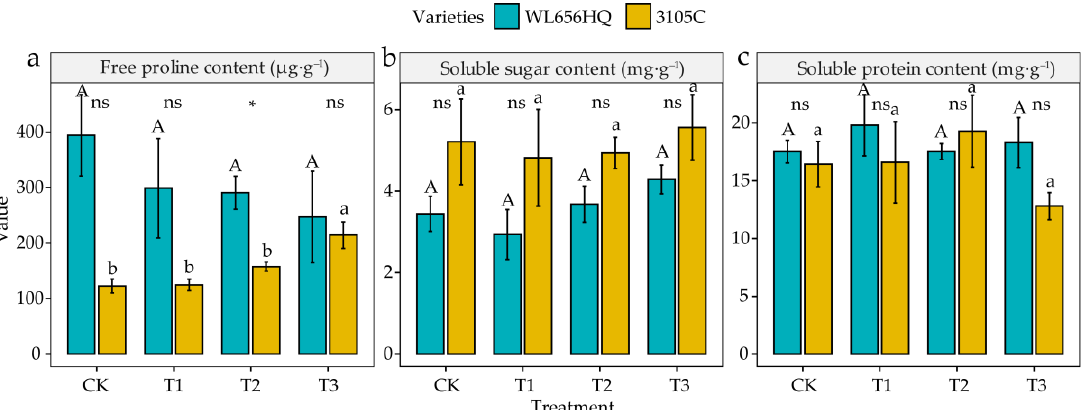
Figure 5. Effects of autotoxicity on proline, soluble sugar and soluble protein content of alfalfa. The blue in the box plot represents the variety WL656HQ; the yellow represents the variety 3105C. The different lowercase and uppercase letters represent the significance of 3105C and WL656HQ at different concentrations. * Indicates the difference between the two varieties. The value p ≤ 0.05 is marked as *. The value p ≥ 0.05 is marked as ns. ( a ) Proline content; ( b ) soluble sugar content; ( c ) soluble protein content.